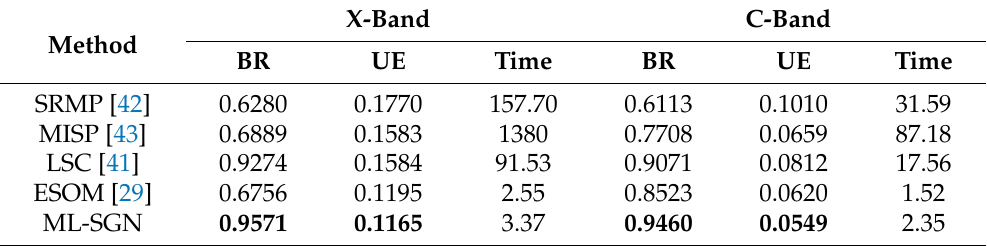
Figure 14. Visualization of deep features extracted by the multitask feature extractor on the C-band SAR image. ( a – d ) are different levels of deep features generated by the proposed method. Table 1. Quantitative evaluation measures of the superpixel generation results using different methods.